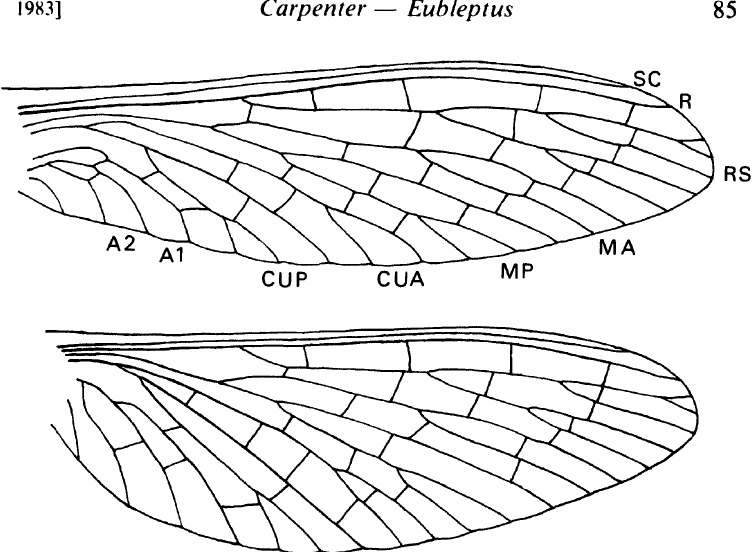
Figure 2. Eubleptus danielsi. Venational diagram of fore and hind wings. SC, subcosta; R, radius; RS, radial sector; M A, anterior media; M P, posterior media; CUA, anterior cubitus; CUP, posterior cubitus; AI and A2, anals. Drawing based mainly on specimen PH 15 Paul Harris collection, with some details from specimens PE32046 and